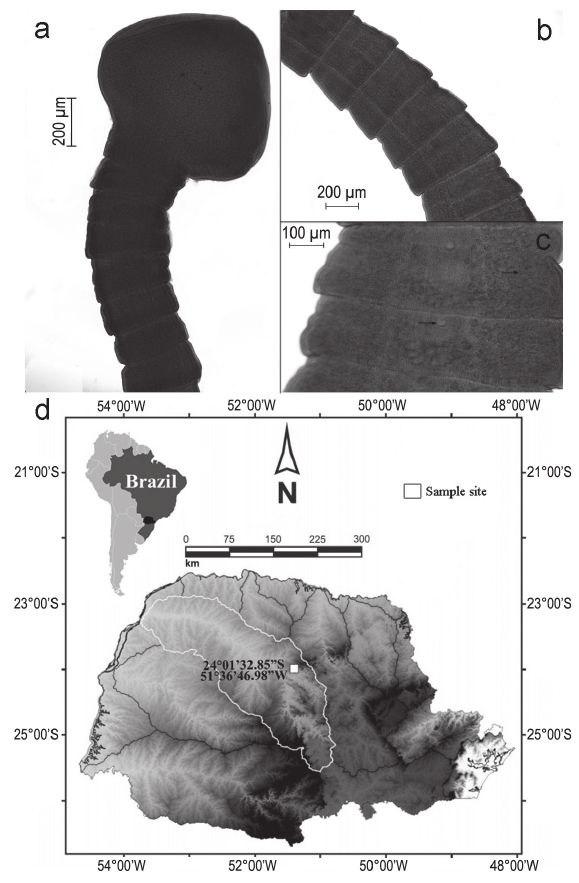
Figure 1 - Schyzocotyle acheilognathi from the fish Rhinelo- ricaria pentamaculata . a. Anterior portion. b . Mature proglot- tids from medial portion. c . Mature proglottids showing genital pore. d . Sampling site of the present study (Lajeadão River, tributary of Ivaí River, municipality of Borrazópolis, Northern Paraná State,